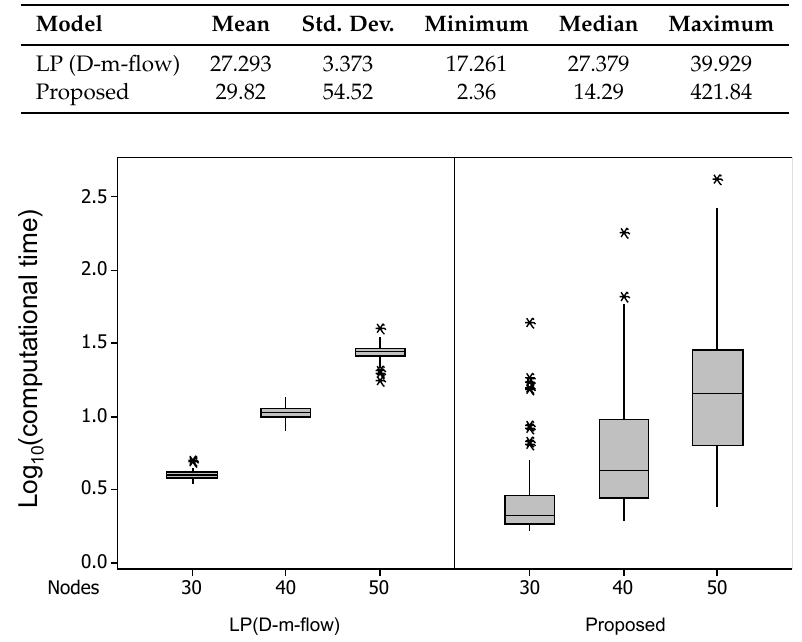
Table 4. Descriptive statistics of the computational times in seconds for the 50-node instances.